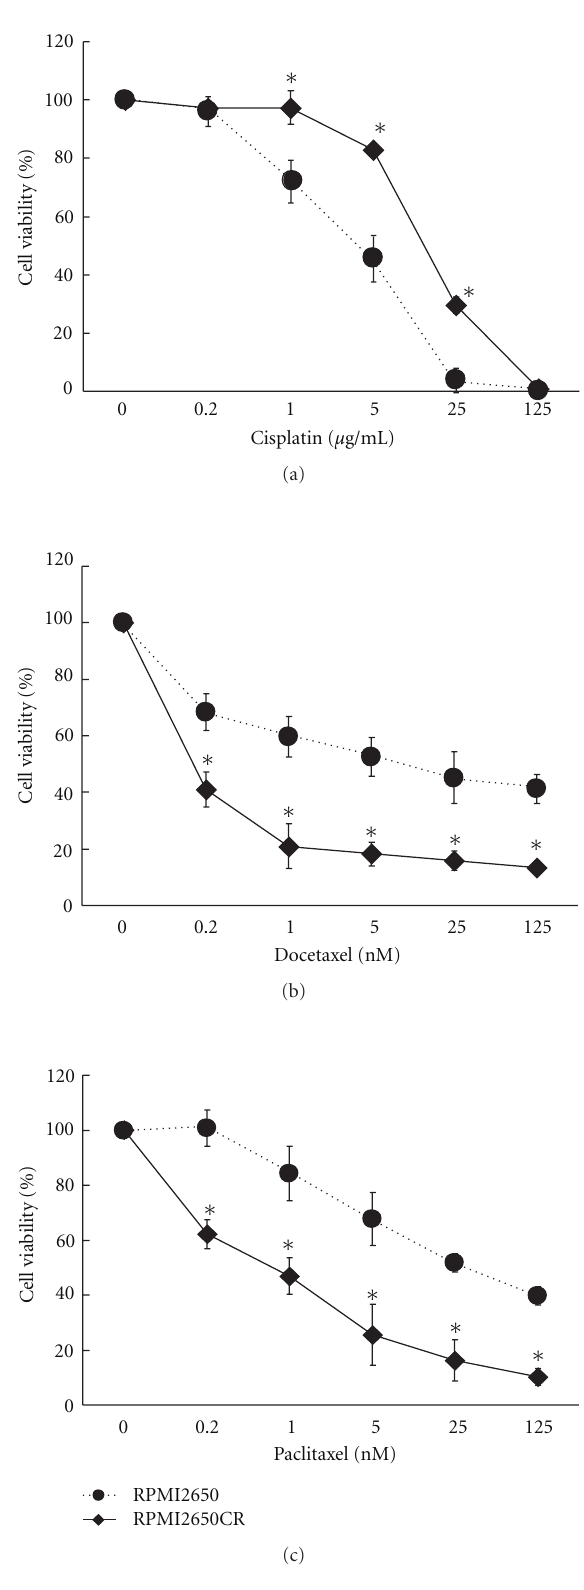
Figure 1: Cell viability with chemotherapeutic agents was assessed by MTT assay. RPMI2650CR shows higher resistance to cisplatin that the parental RPMI2650 (a) but has higher sensitivities to both docetaxel (b) and paclitaxel